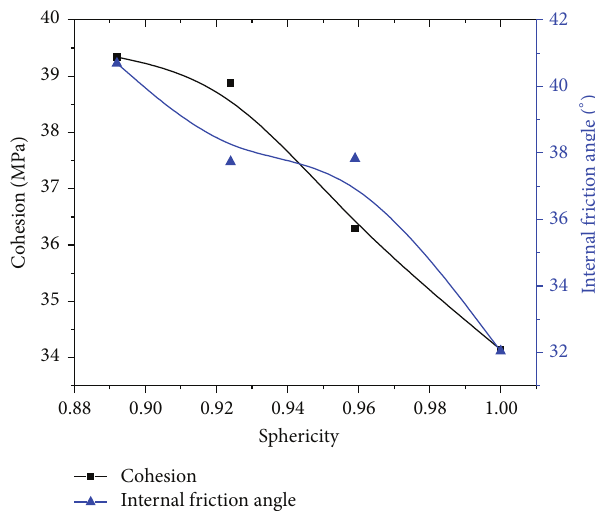
Figure 11: The relation among the crack initiation stress, crack damage stress, and sphericity.